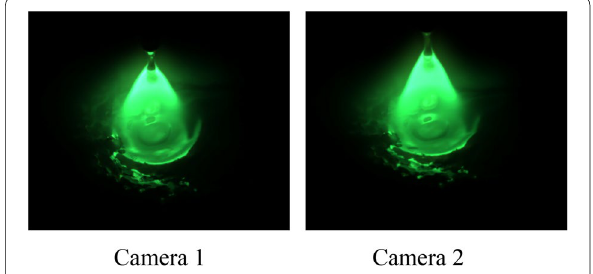
Figure 5 Captured images of the welding pool under the arc (240 A, 33 V, 0.6